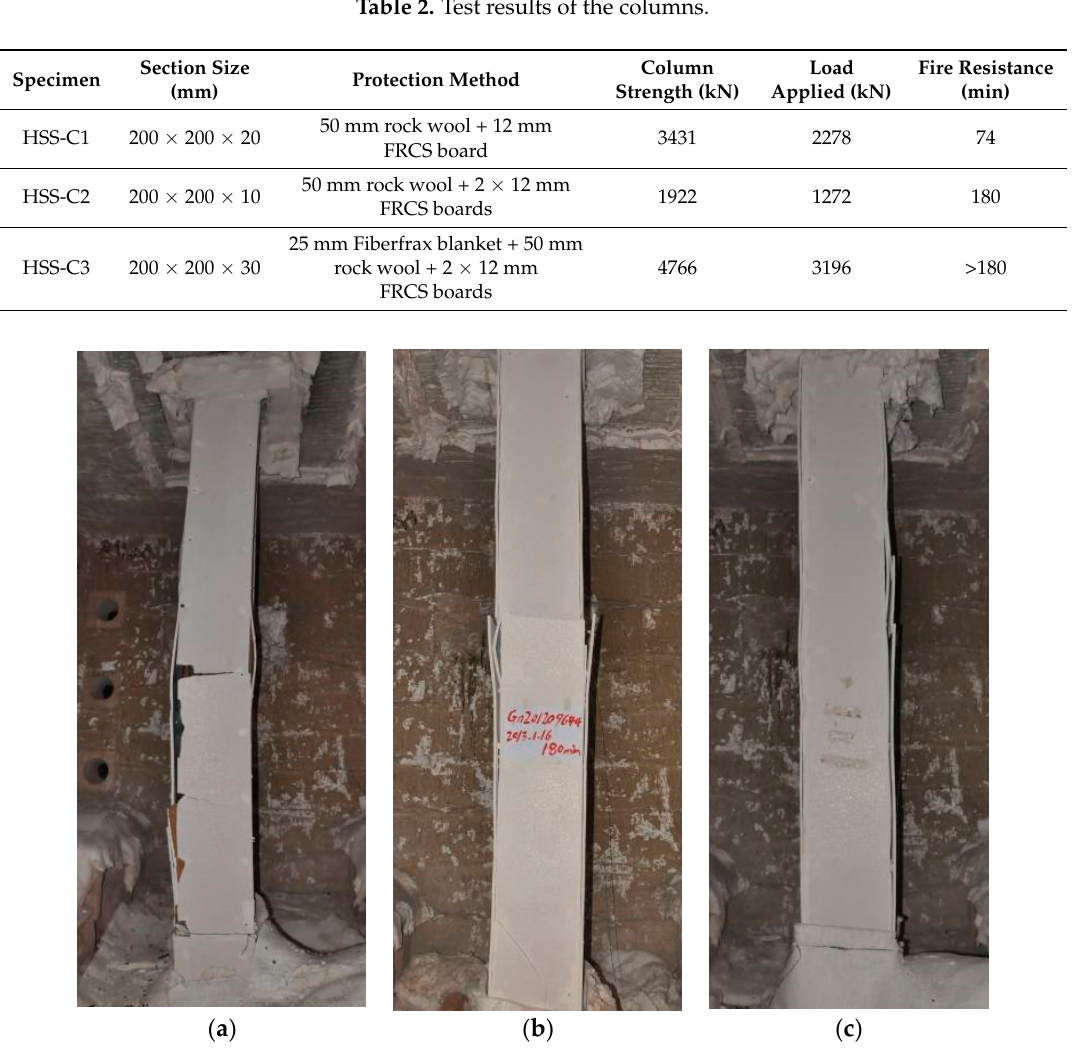
Figure 6. Columns after tests (still in the furnace): ( a ) HSS-C1; ( b ) HSS-C2; ( c ) HSS-C3.